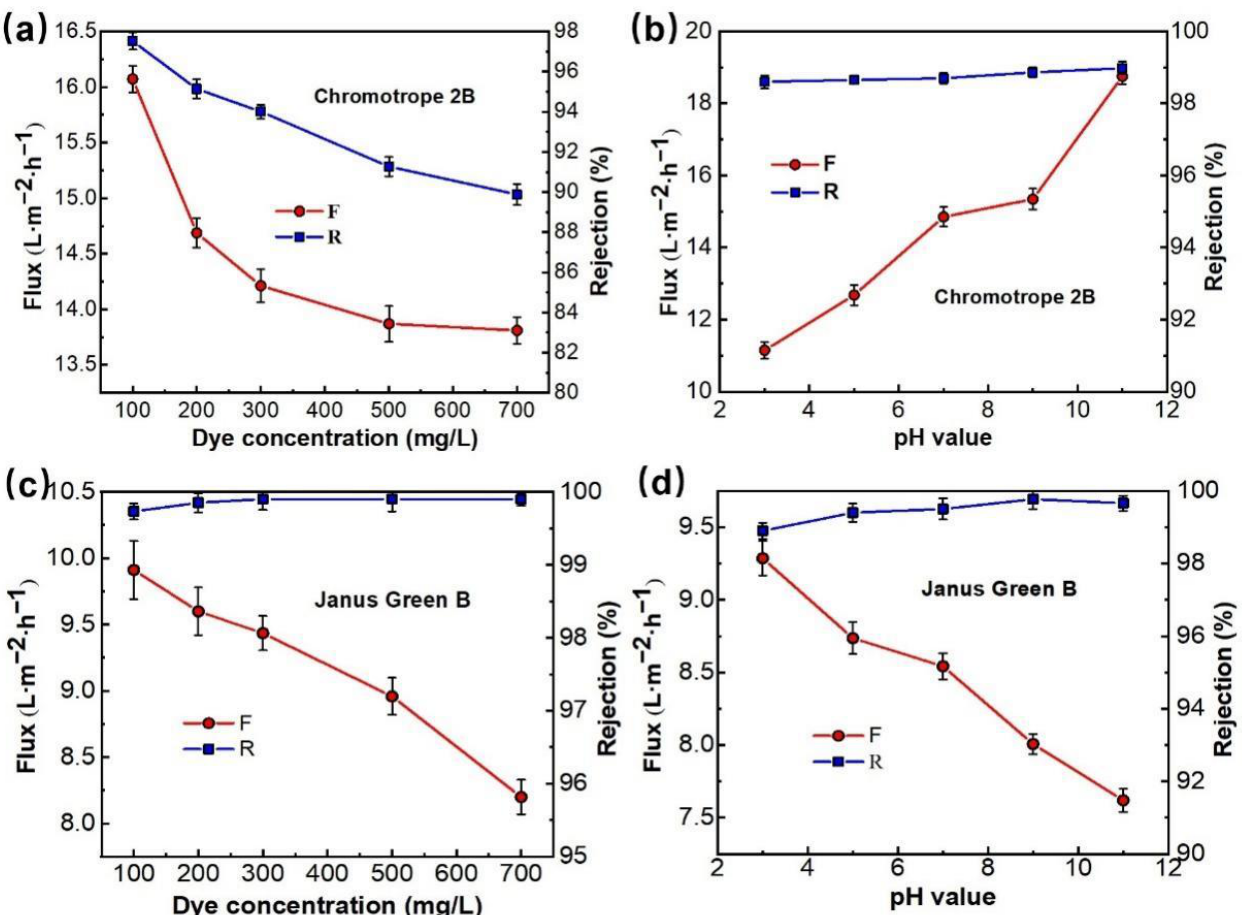
Figure 9. The effect of the dye concentration ( a , c ), pH value ( b , d ), on separation performance